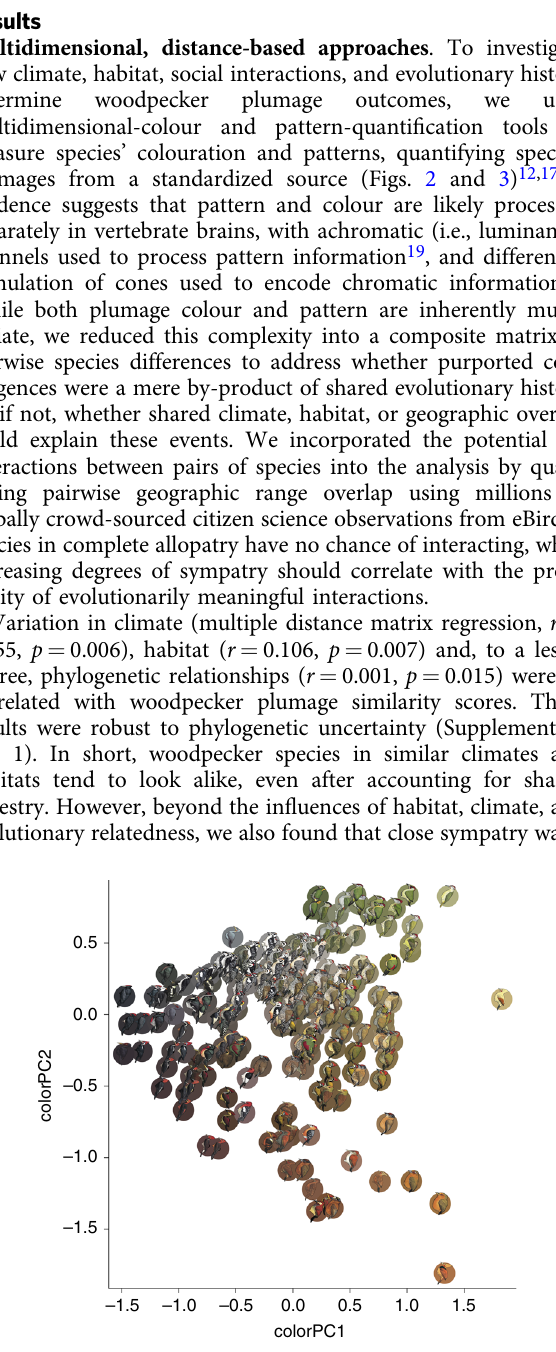
Fig. 2 Principal components analysis (PCA) of species-averaged woodpecker colour values. Principal component one (colourPC1) explains 45% of the variation in measured colour scores. Higher PC1 scores correspond to greater luminance values, and more yellow and less blue. Principal component two (colourPC2) explains an additional 36% of variation in overall colour scores. Higher PC2 scores correspond to more green and less red colouration. Coloured circles behind each woodpecker species correspond to the average CIE L*a*b scores for the 1000 randomly drawn colour samples from that species. These PCA values are used for species-level analyses (e.g., Fig. 5). Illustrations © HBW